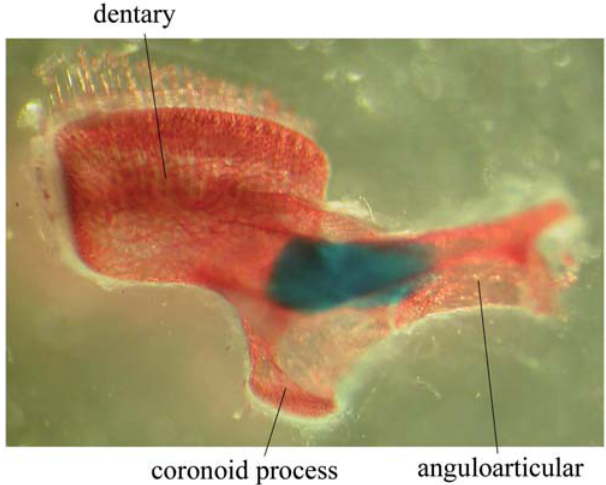
Fig. 30. Dorsal view of dentary and anguloarticular (left side) of Pterosturisoma microps (MZUSP 79909, 75.9 mm SL).